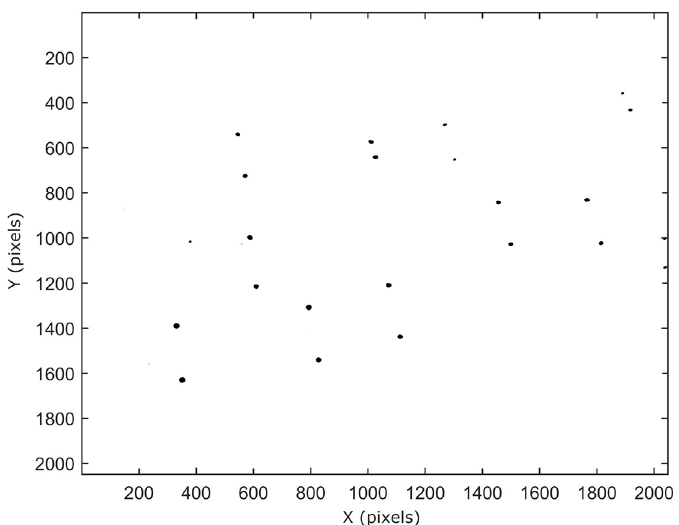
Figure 3. Multi-exposure image taken from particles moving underneath the first camera system (inverted image after thresholding operation; units in image coordinates). The spreader was set at configuration A.